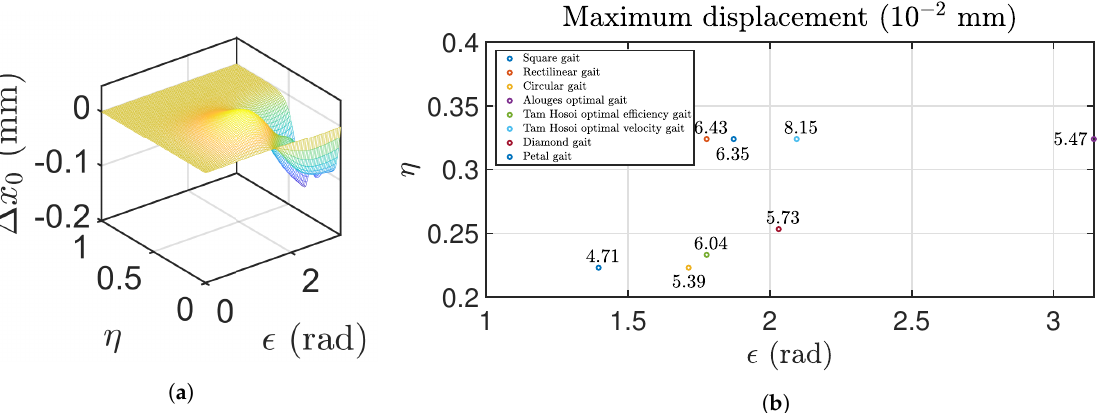
Figure 7. Results for optimal displacement: ( a ) 3D plot of displacement applying the square gait to the Purcell’s three-link swimmer, ( b ) maximum values of displacement with their corresponding gait amplitude ( (cid:101) ) and relation between lengths of the links ( η ).